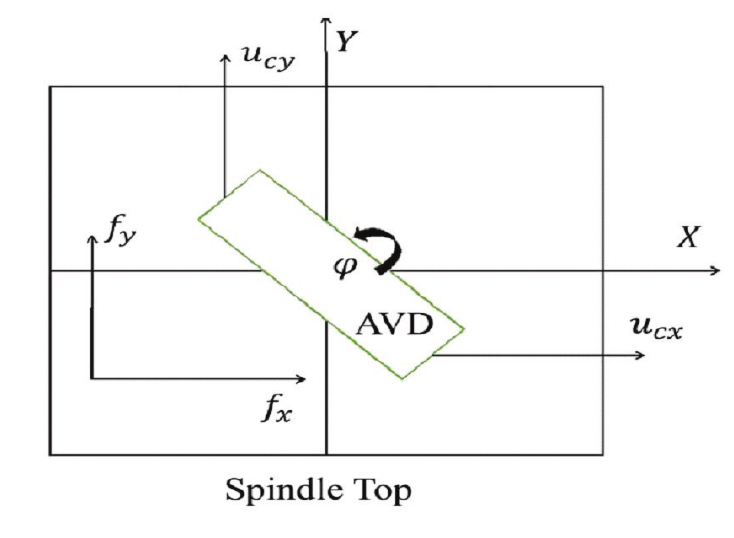
Figure 2. AVD on Spindle